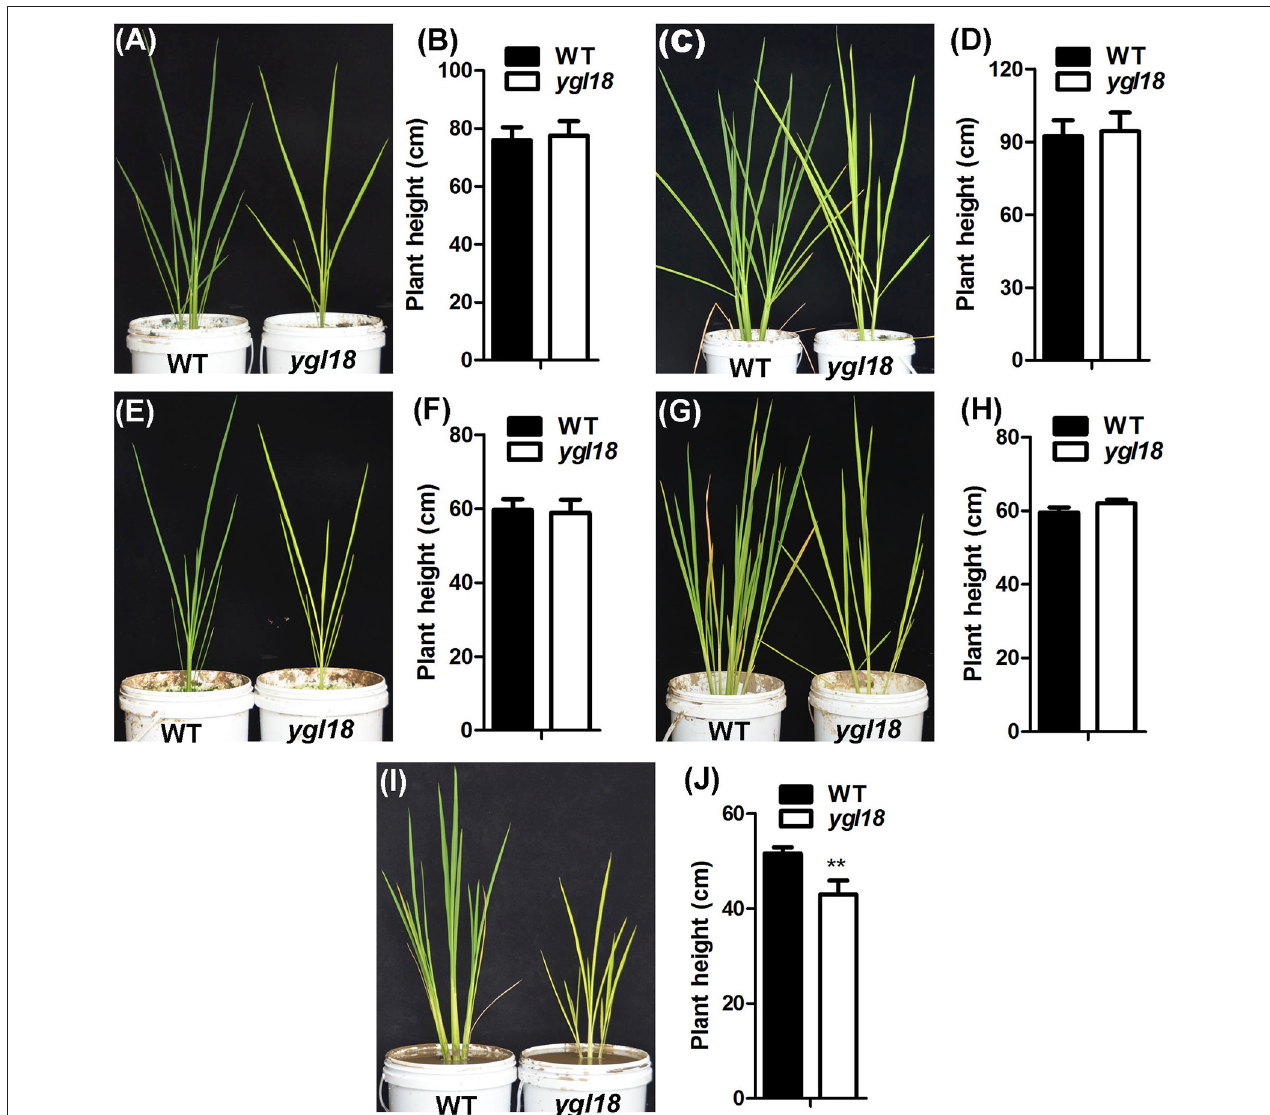
FIGURE 10 | Growth of the wild-type and ygl18 plants under different experimental conditions in the plant growth chamber. Fifteen-day-old seedlings (28/22 ◦ C, 14/10h, light/dark, 190 µ mol m − 2 s − 1 ) were used for the following experimental conditions. (A) Plants grown for about 60 days under the condition of 26/19 ◦ C, 14/10h, 190 µ mol m − 2 s − 1 . (B) Plant height under the condition in (A) . (C) Plants grown for about 60 days under the condition of 31/22 ◦ C, 14/10h, 190 µ mol m − 2 s − 1 . (D) Plant height under the condition in (C) . (E) Plants grown for about 30 days under the condition of 35/22 ◦ C, 14/10h, 190 µ mol m − 2 s − 1 . (F) Plant height under the condition in (E) . (G) Plants grown for about 30 days under the condition of 31/22 ◦ C, 14/10h, 500 µ mol m − 2 s − 1 . (H) Plant height under the condition in (G) . (I) Plants grown for about 23 days under the condition of 31/22 ◦ C, 14/10h, 900 µ mol m − 2 s − 1 . (J) Plant height under the condition in (I) . Data represent the mean ± SD of three independent plants (Student’s t -test: ** P <